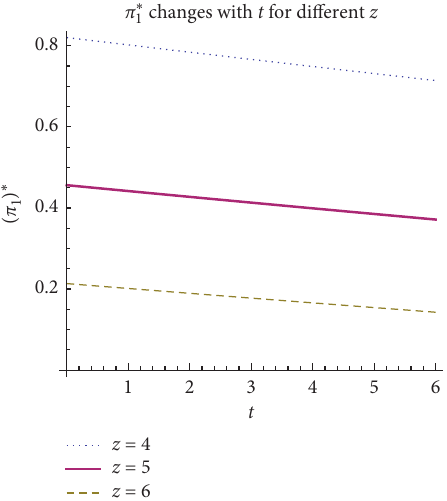
Figure 5: Values of π ∗ liability ratio z